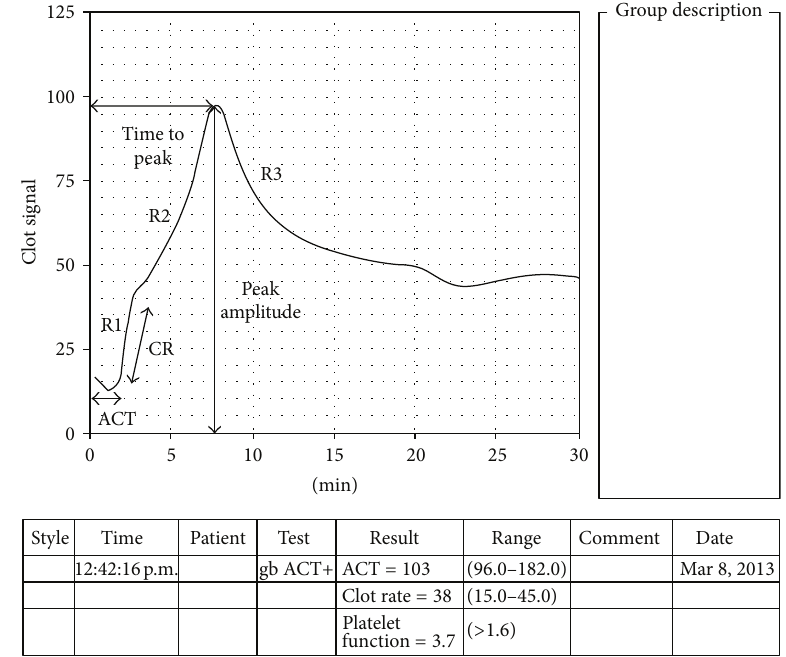
Figure 1: Normal sonoclot signature ACT (SONACT: activated clotting time), CR: clot